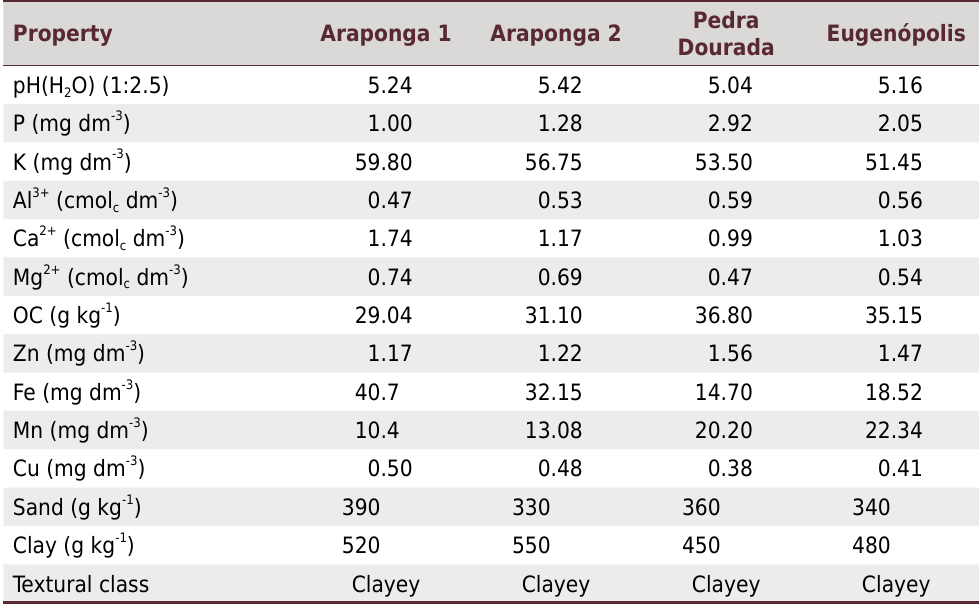
Table 1. Chemical and physical properties at the depth of 0.00-0.2 m of the soils before setting up the experiments